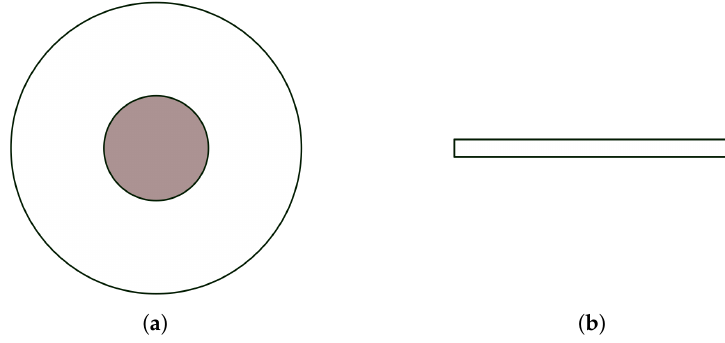
Figure 7. ( a ) Paper roll side face, ( b ) Extended paper side face.